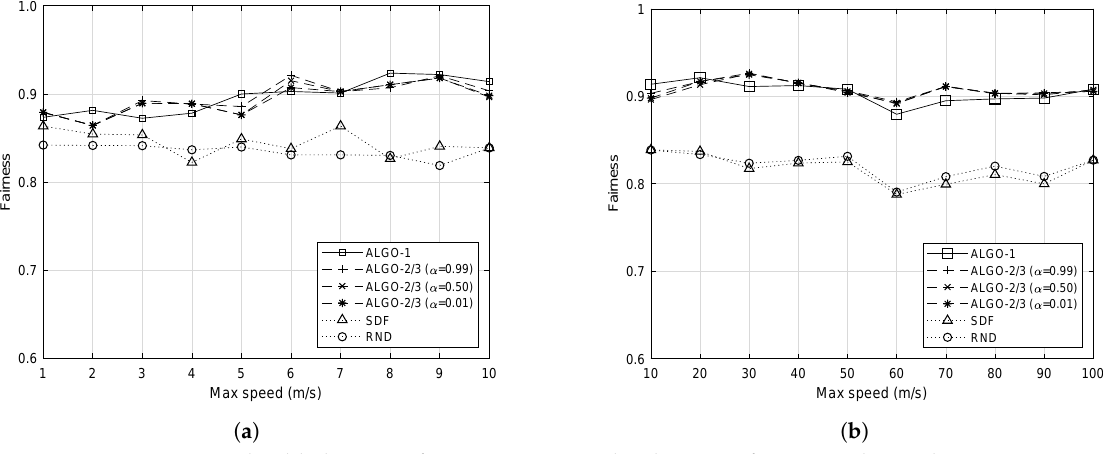
Figure 5. Average load balance performance measure by the Jain’s fairness index with respect to different upper bounds on the speed of 50 mobile IoT devices. ( a ) When IoT devices are moving at a slow speed; ( b ) When IoT devices are moving at a fast